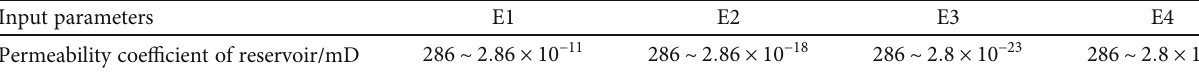
Table 7: Input parameters of scenario E.